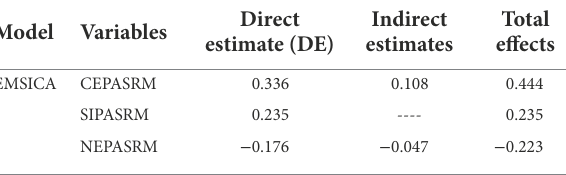
TABLE 5 The results of indirect and total effects on IPASRM in the EMSICA. Model